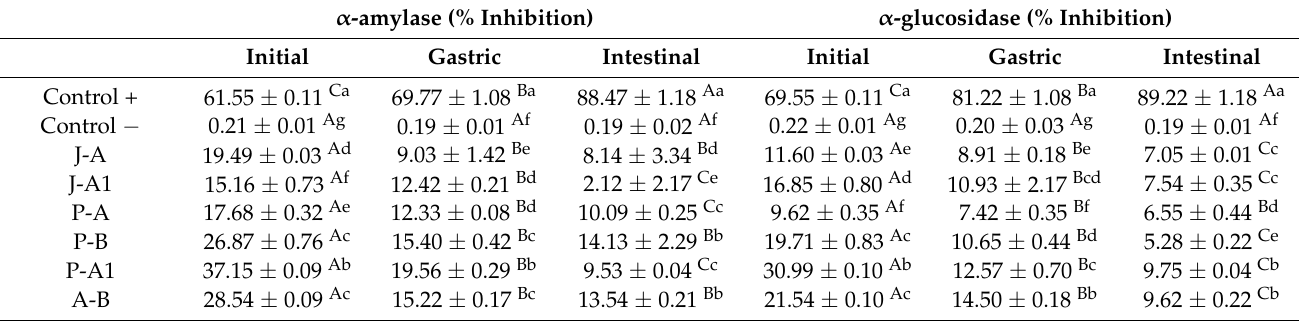
Table 3. Effect of in vitro digestibility on enzyme